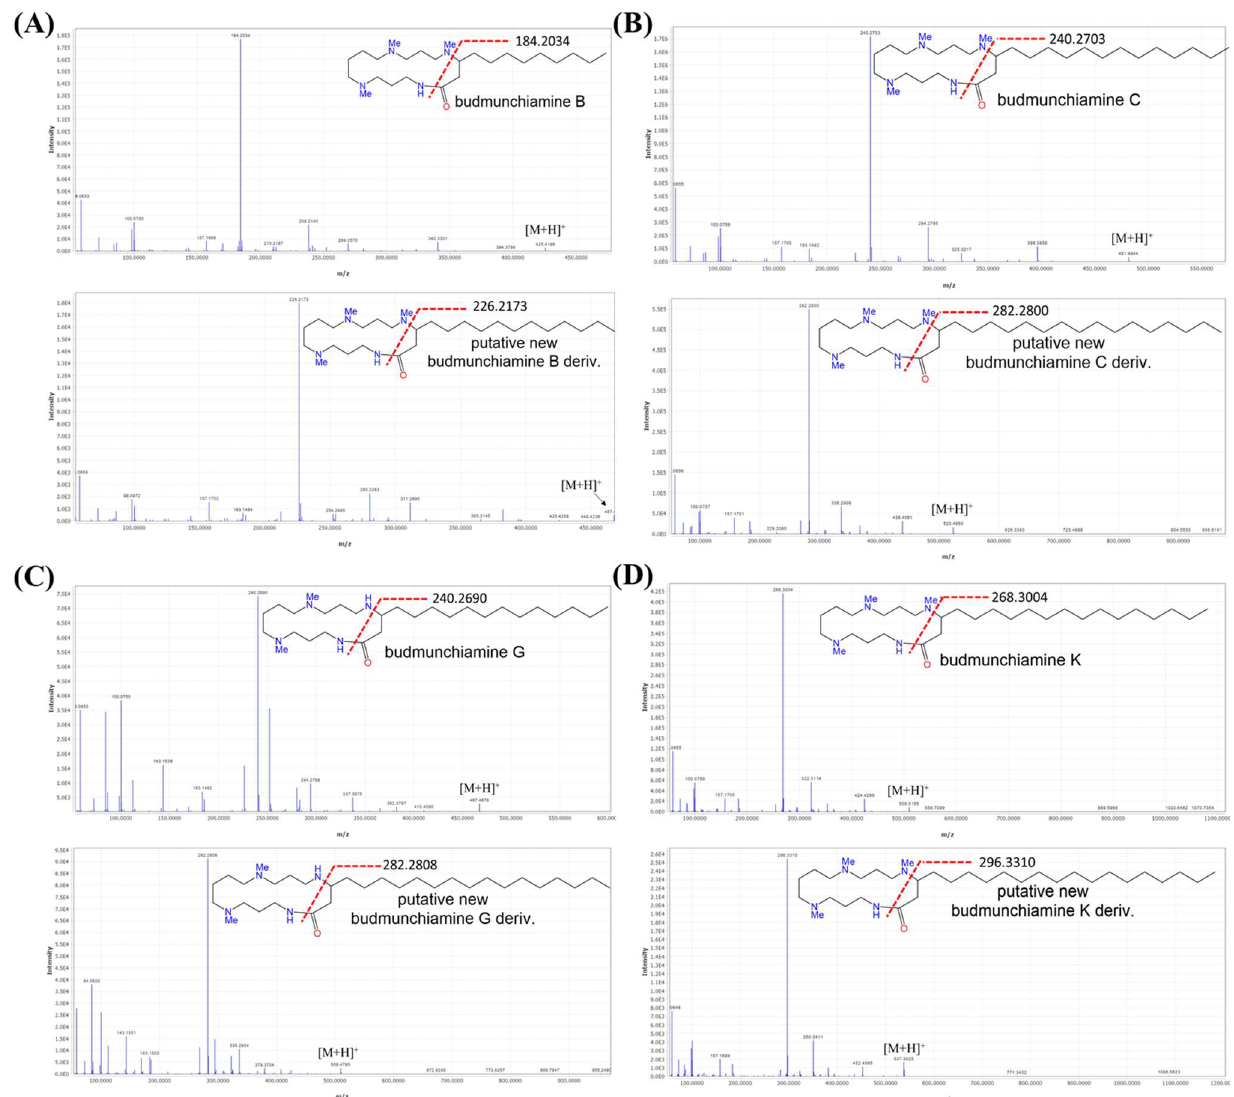
Figure 3. MS/MS fragmentation of budmunchiamine alkaloids and their putative derivatives: ( A ) budmunchiamine B; ( B ) budmunchiamine C; ( C ) budmunchiamine G and ( D ) budmunchiamine k, respectively.